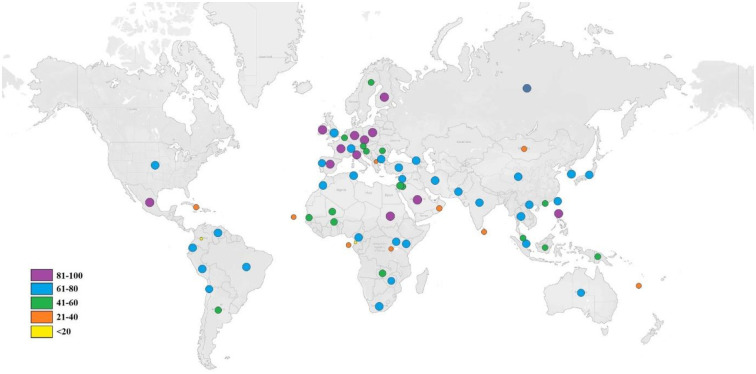
Worldwide population coverage of the selected for the multi-epitope vaccine.Global distributions of the selected epitopes are indicated by circles. Circle of different colors represents different ranges of population coverage.